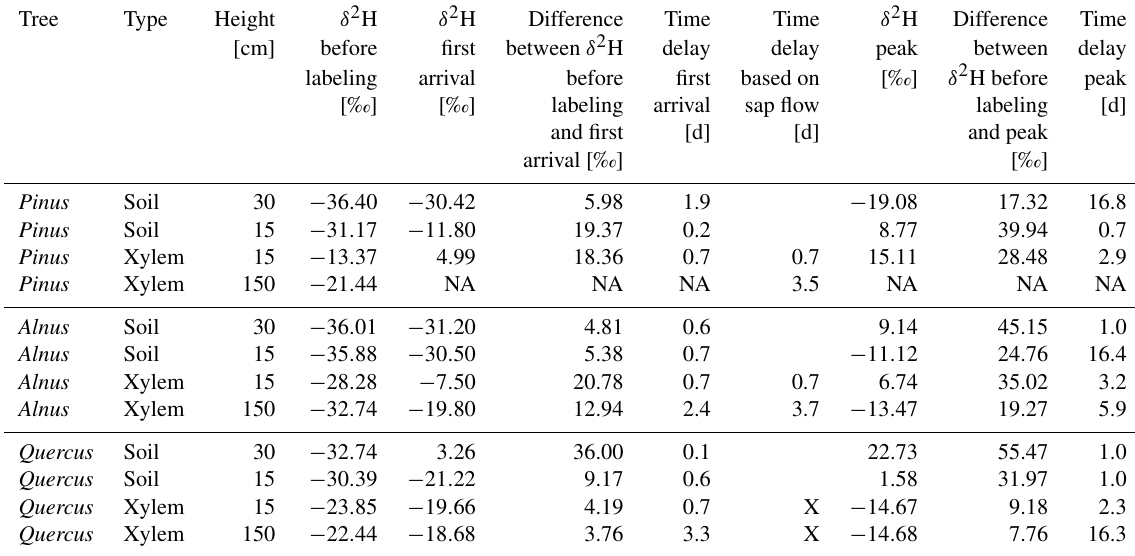
Table 5. Tracer arrival and peak times in xylem isotope probes at 15 and 150cm height in Pinus , Alnus and Quercus of the first labeling on 17 September 2019. In addition, an estimated time delay based on cumulated sap flow velocity data is given. It is calculated as the time needed for sap to travel from − 15cm average rooting depth to 15 and 150cm stem height, respectively.